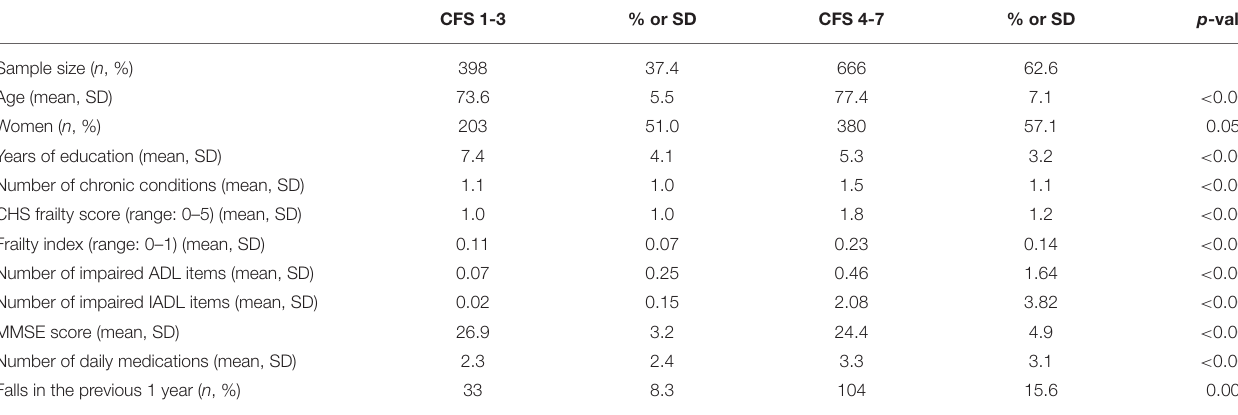
TABLE 1 | Basic demographic and clinical